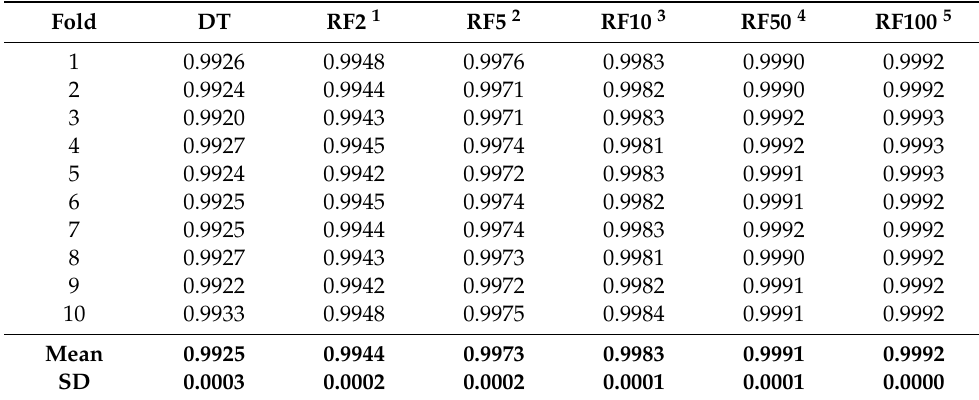
Table 3. AUROC for Net-Net AutoML classification models.